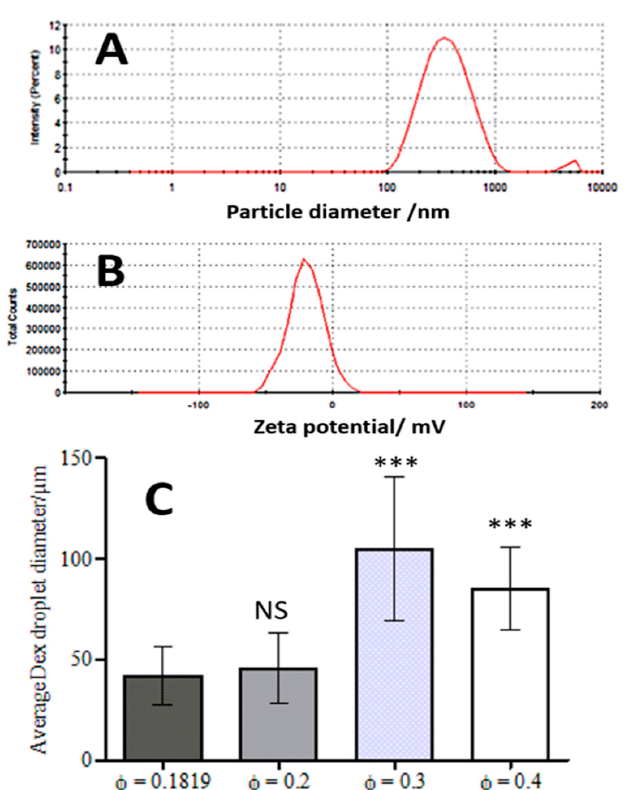
Figure 2. The average hydrodynamic diameter ( A ) and zeta-potential ( B ) for the produced WP particles at pH 5.8. ( C ) Average DEX droplet diameter for the DEX/PEO Pickering emulsion produced from WP/NaCl 300 mM solution at pH 5.8, 5.5 wt% PEO/5.5 wt% dextran for varying volume fractions of the Dextran phase (average of 200–300 individual drops). The data were obtained by optical microscopy measurements of the DEX droplets for each micrograph with Image J software. (Student’s t -Test, NS: Non-significant, *** p < 0.001).